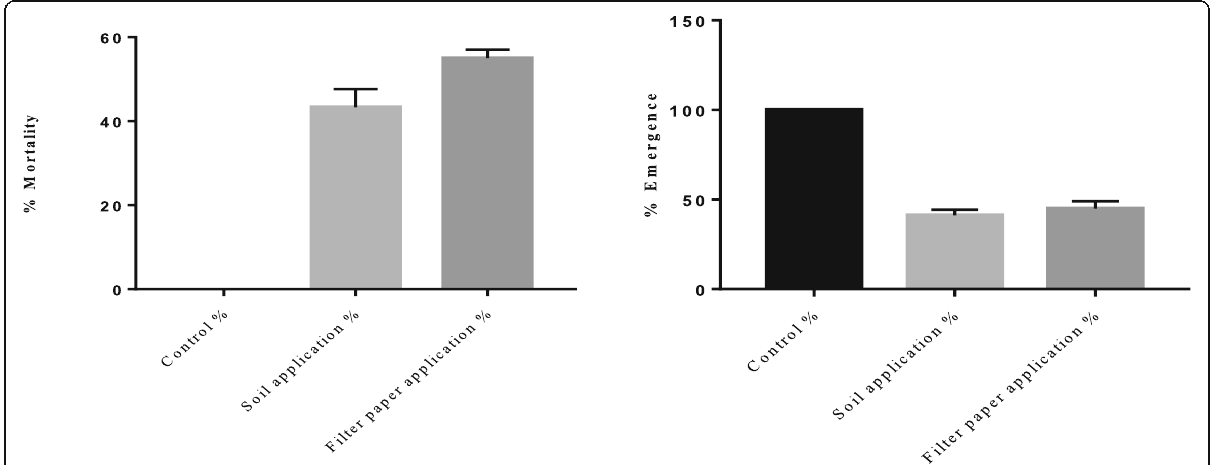
Fig. 1 Percentage mortality and emergence rate (Means+SE) of Ceratitis capitata larvae treated with Beauveria bassiana BMAUM M6-4 suspension (at 10 7